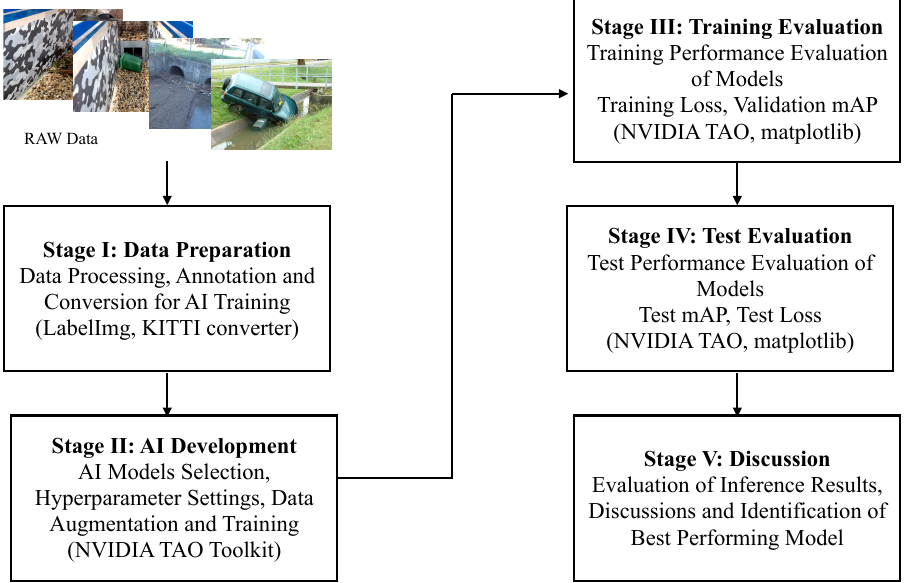
Figure 3. Functional Block Diagram of the Proposed Research Methodology for Floodborne Object Type